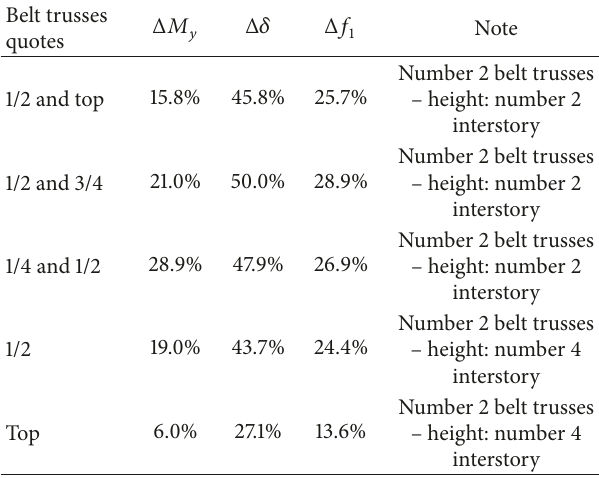
Table 8: Comparisons between the original building and the solution proposed in Case 1, n. 4 interstories in height and n. 2 lines in horizontal length: Case 1.